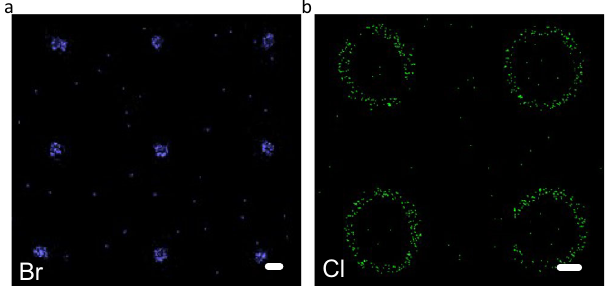
Fig. 5 SEM-EDS analyses. a EDS elemental mapping of bromine (Br,